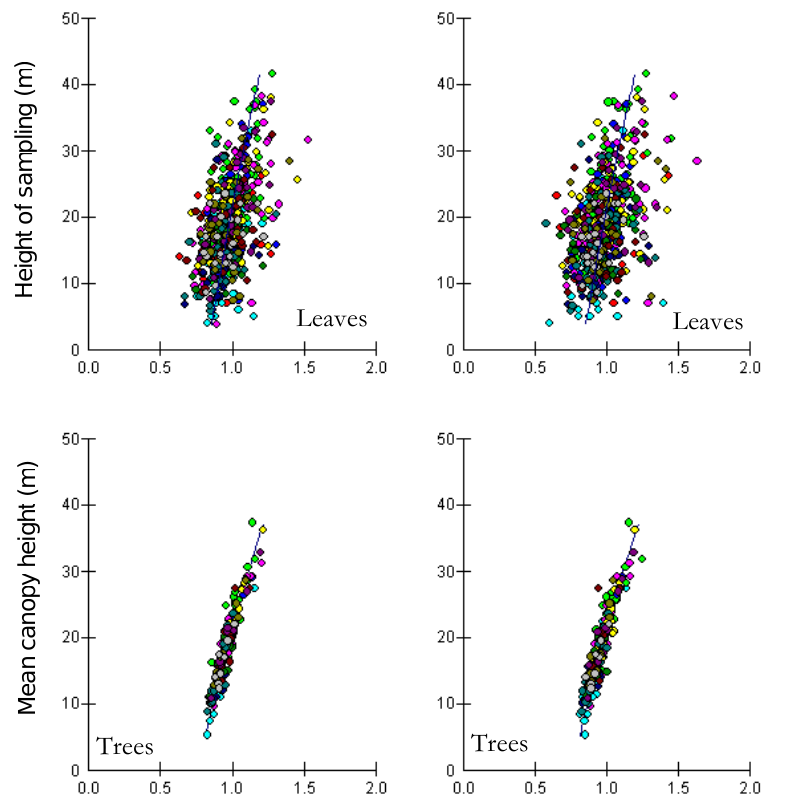
Fig. 8. Vertical gradients in leaf [N], and leaf [P] expressed on a leaf area basis. Different colours refer to different